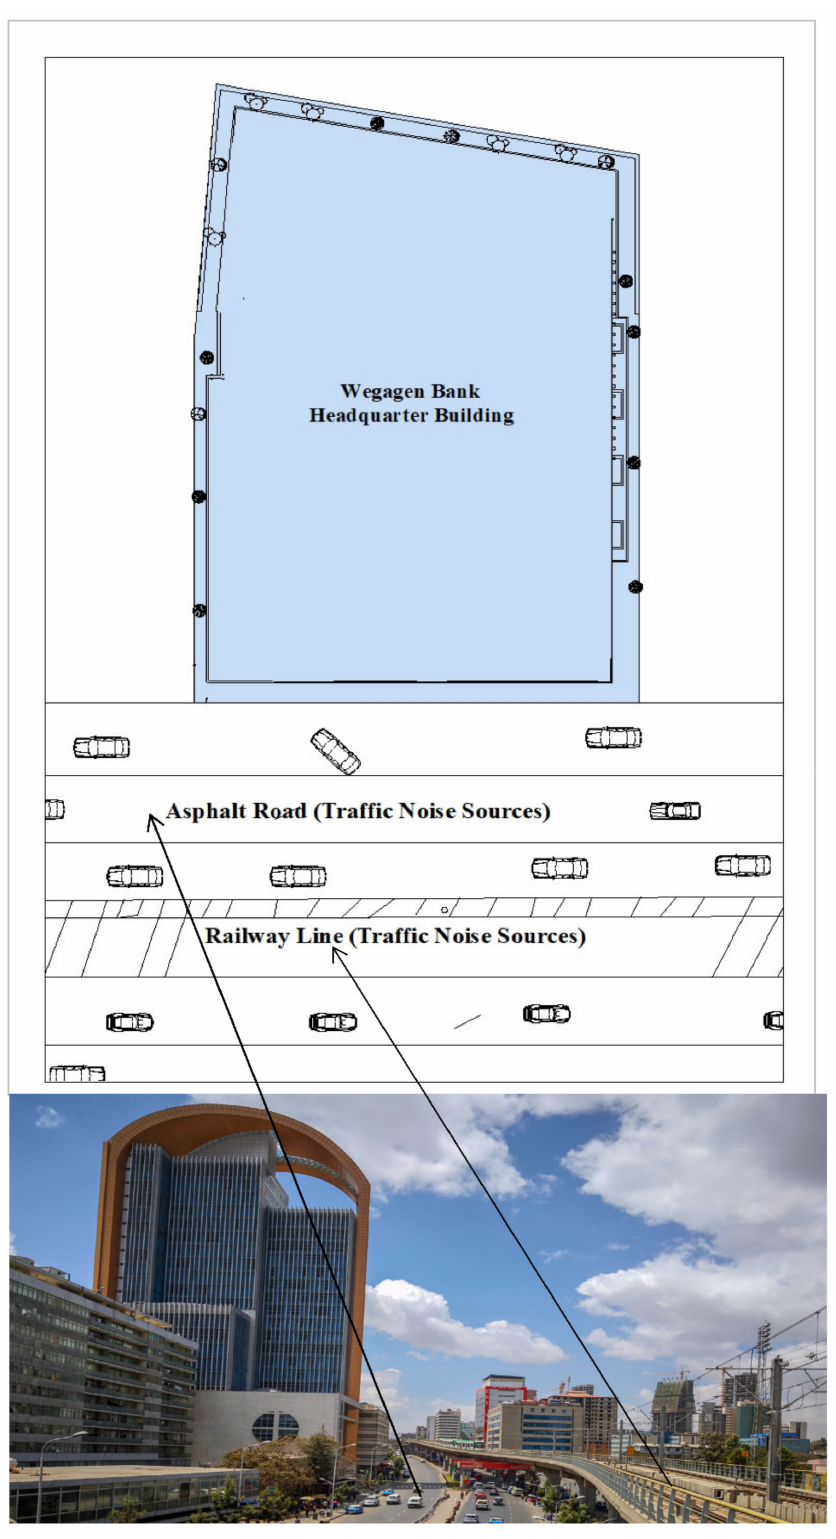
Figure 5. Traffic noise pollution sources near to the